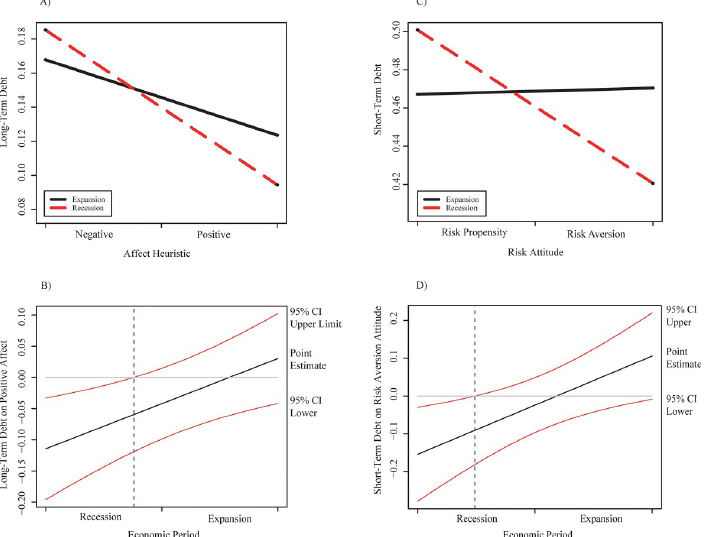
Fig 2. Interactions and confidence intervals graphs of the relation of traits and long-term and short-term debt. A) Graph of simple slopes of positive affect heuristic of CEOs on long-term debt in function of the economic situation. B) Confidence intervals of positive affect of CEOs on long-term debt for the two economic periods. C) Graph of simple slopes of adverse risk attitude of CEOs on short-term debt in function of the economic situation. D) Confidence intervals of adverse risk attitude of CEOs on short-term debt for the two economic